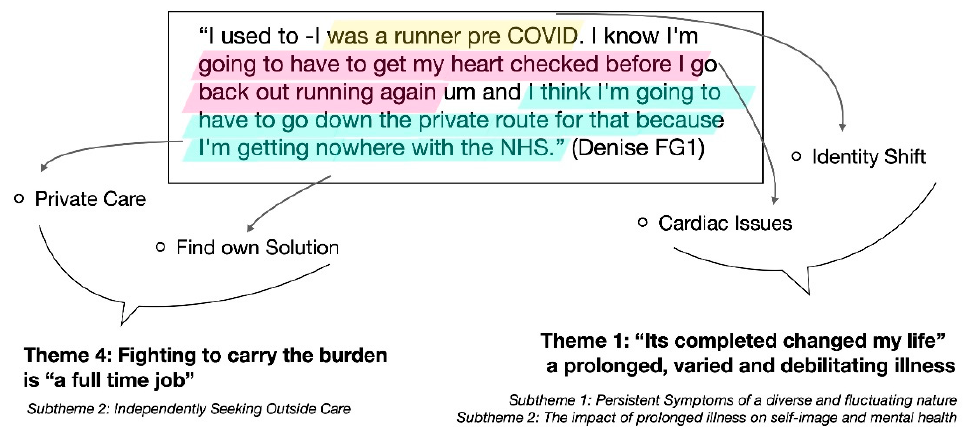
Figure 2. An image depicting the thematic analysis technique. Labels are presented with circle bullets, themes are presented in bold, and subthemes are presented in italics.